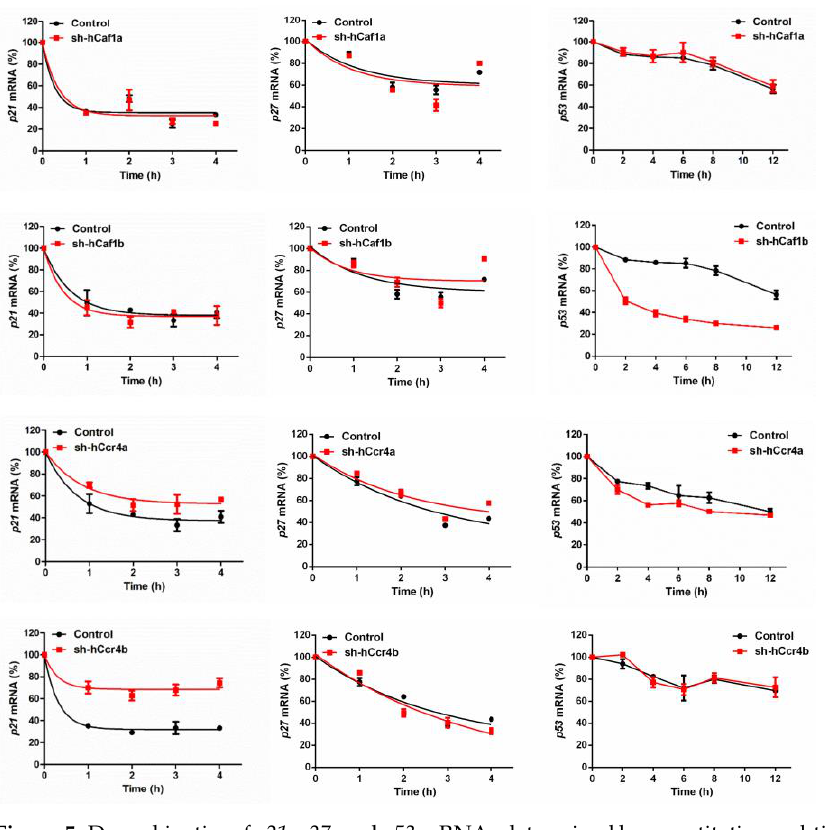
Figure 5. Decay kinetics of p21 , p27, and p53 mRNAs determined by quantitative real-time PCR ( n = 3).